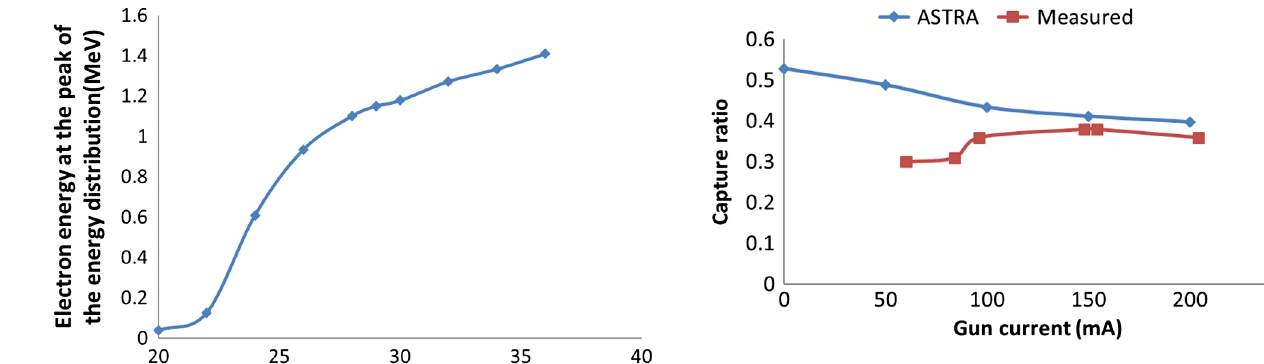
FIG. 13. Beam capture ratio as a function of the dc current from the electron gun.